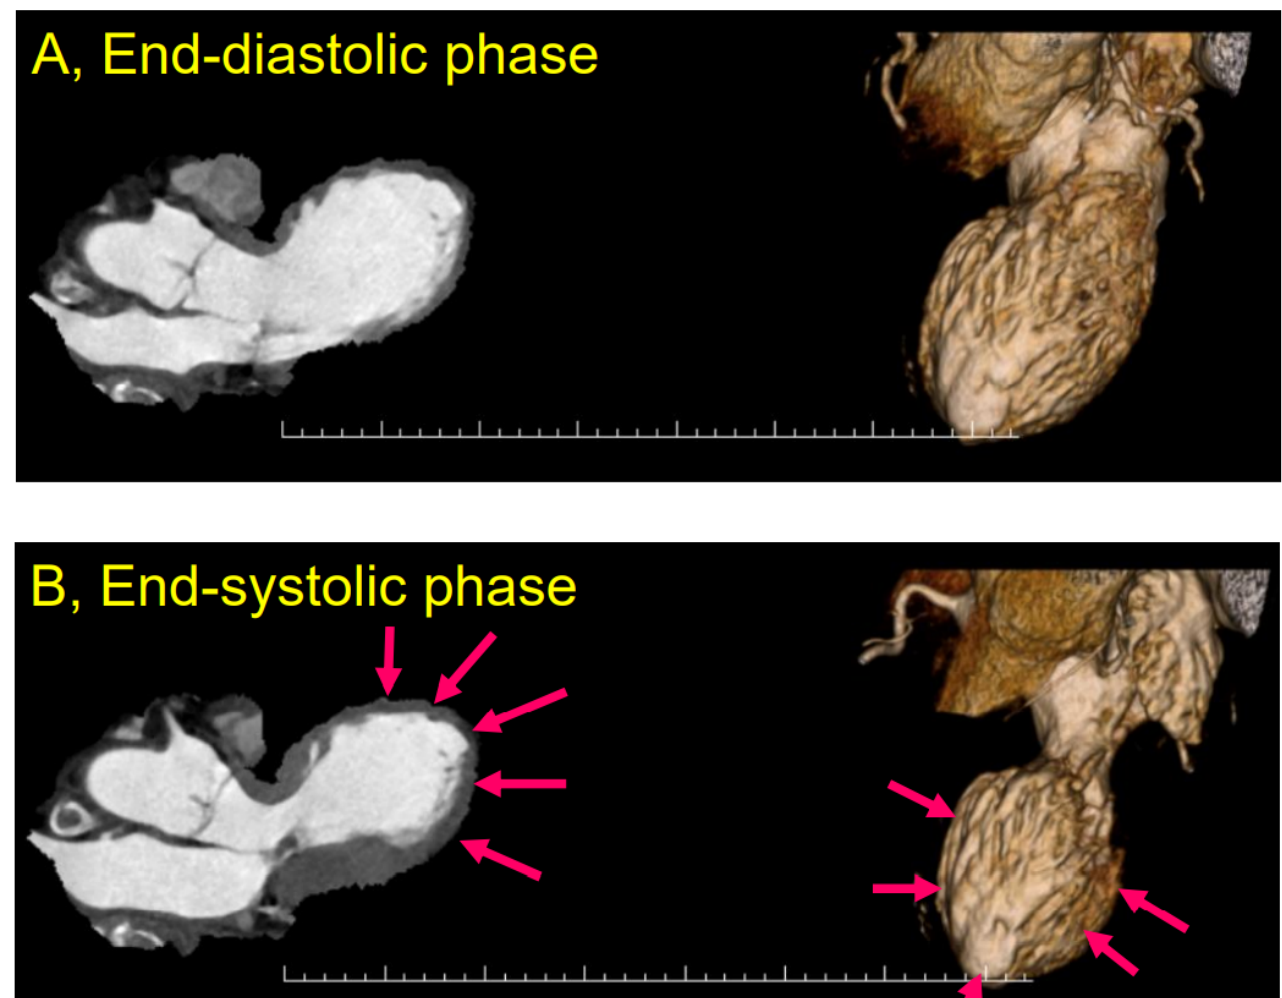
Figure 2. Left ventricular images assessed by computed tomography (CT) in Takotsubo syndrome (TTS). End-diastolic-phase left ventriculogram ( A ) and end-systolic-phase left ventriculogram ( B ). The extensive area around the apex portion shows akinesis (arrows), and the basal segments display hypercontraction, especially in the end-systolic phase ( B ). From [82].